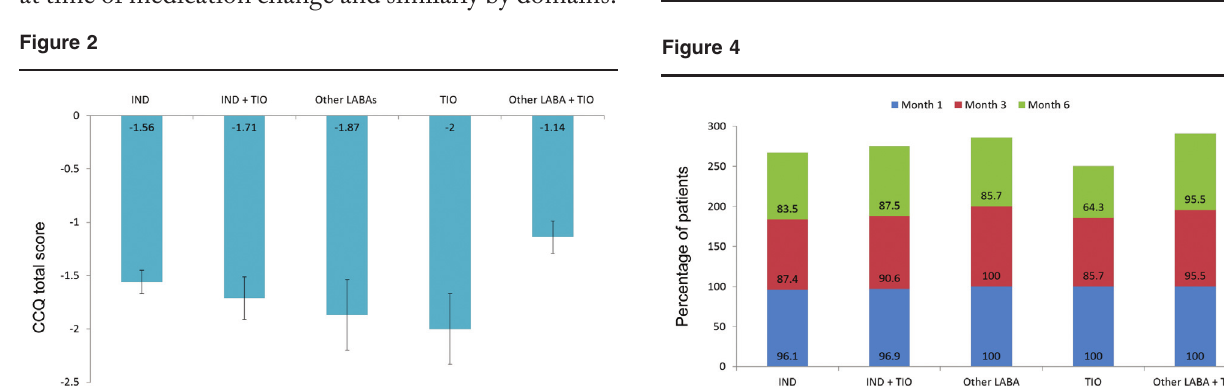
Changes from baseline in CCQ scores by domain (symptom, func- tional state and mental state) in per-protocol set (last observation carried forward). Data are mean±SE; all P < 0.0001 for change in CCQ scores by domain from baseline to the end of the study. CCQ, Clinical COPD Questionnaire; LABA, long-acting β 2 -agonist; TIO, tiotropium; IND, indacaterol.